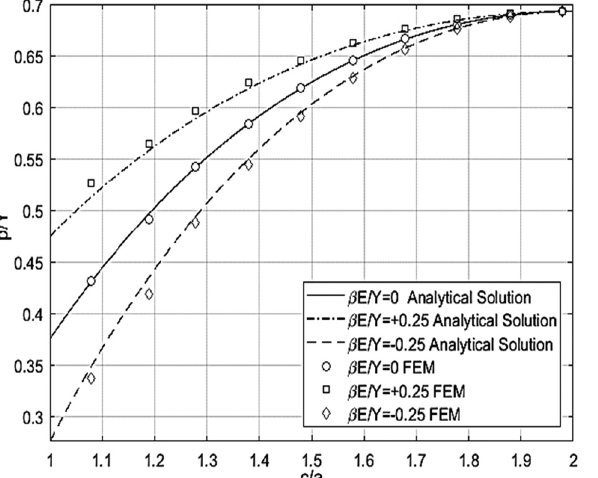
Figure 5: Distribution of hoop stresses in an elastic – plastic cylinder subjected to internal pressure when β = 0.25.